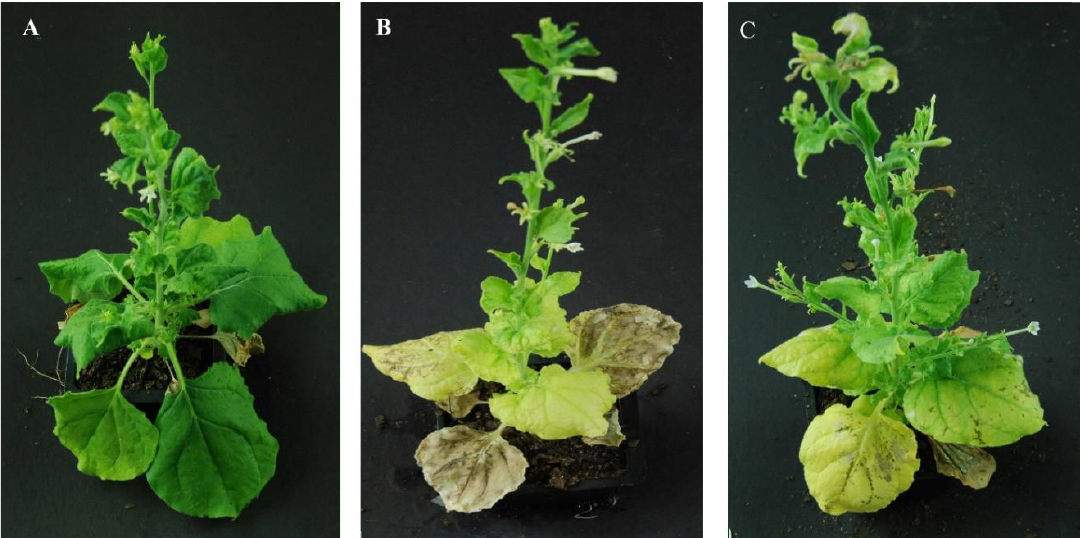
Figure 2. Mature proteins of CLIBASIA_03915 (m03915) and CLIBASIA_04250 (m04250) caused the phloem necrosis in senescent leaves of Nicotiana benthamiana . Plants expressing control green fluorescent protein (GFP) did not show phloem necrosis ( A ). On the contrary, expression of m03915 ( B ) and m04250 ( C ) by tobacco mosaic virus in N. benthamiana plants caused phloem necrosis in senescent leaves. The pictures were taken at 5 weeks post infiltration (WPI).